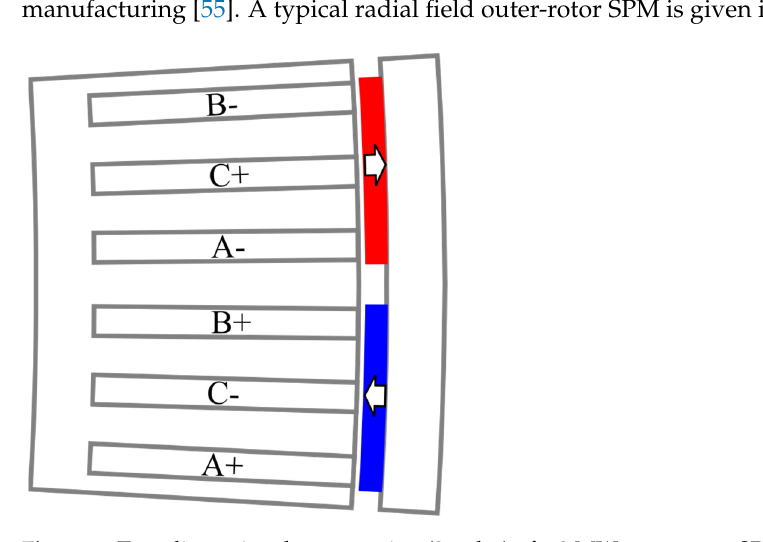
Figure 2. Two-dimensional cross section (2 poles) of a 3 MW outer-rotor SPM [56].